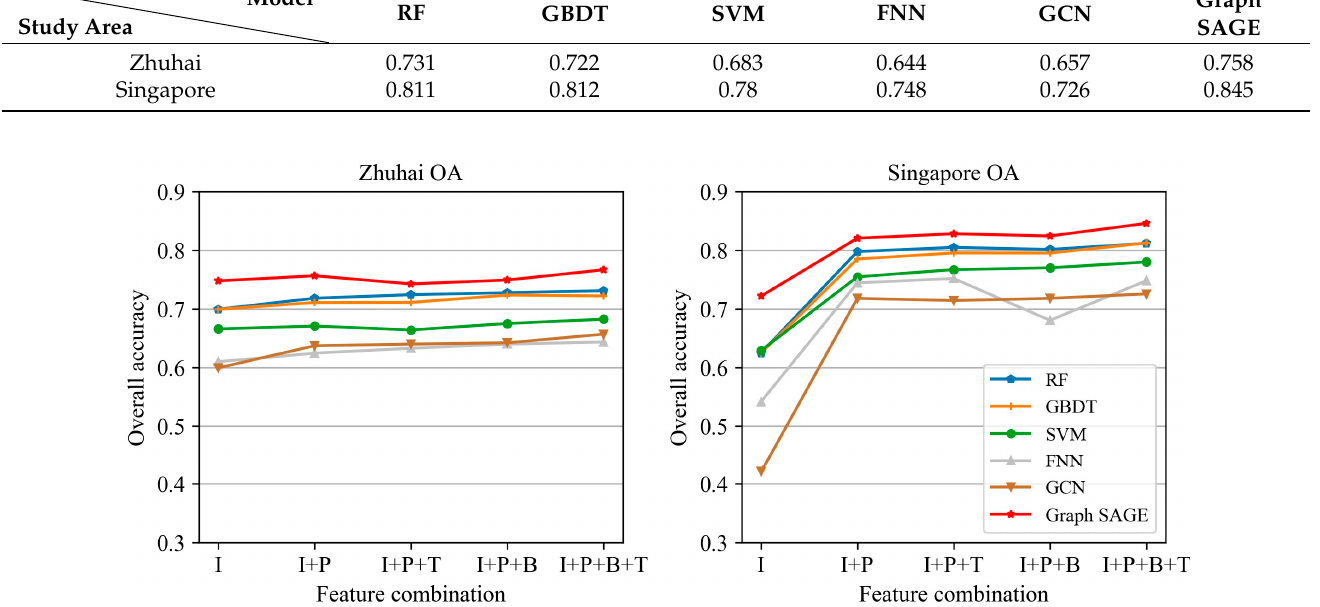
Figure 15. Overall accuracy of different